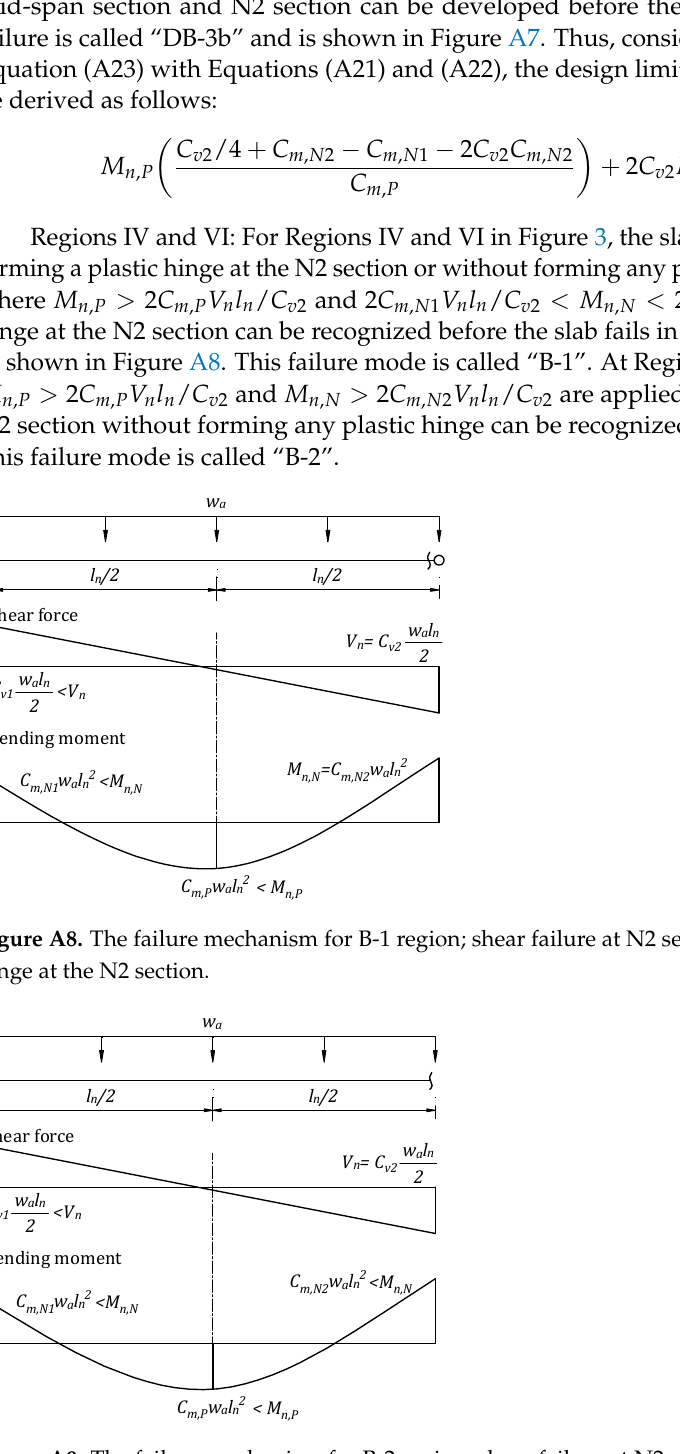
Figure A7. The failure mechanism for DB-3b region. ( a ) Flexural failure at the mid-span section first; next, ( b ) flexural failure at the N2 section; and finally, ( c ) shear failure at the N2 section.